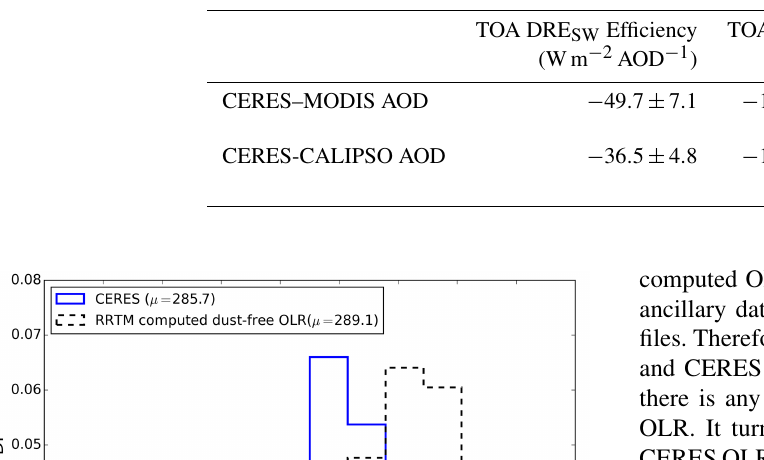
Table 1. Observation-based instantaneous (at A-Train overpassing time) DRE and DRE SW efficiency at the top of the atmosphere (TOA). The values in the parentheses for DRE LW are based on the assumption of 0.7Wm − 2 bias in our clear-sky OLR computation. See text for details.